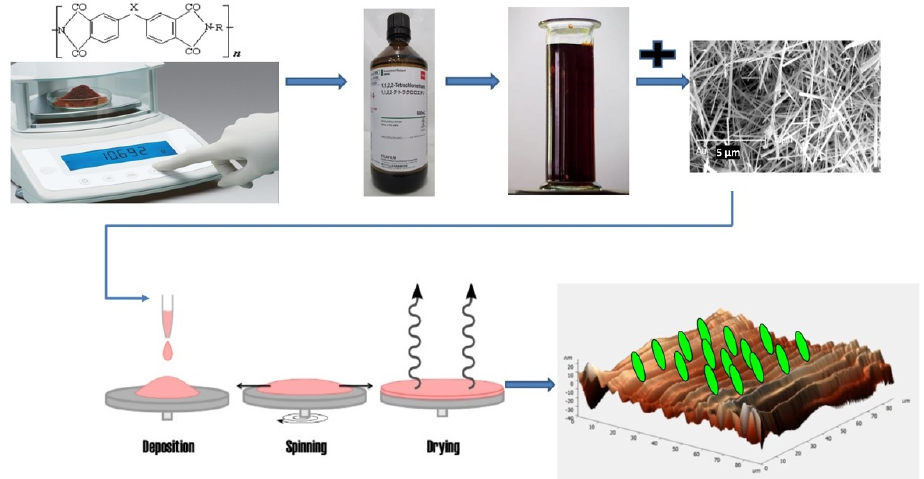
Figure 1. Schematic illustration of the process for preparing the relief structure of the PI film surface with WS 2 nanotubes as dopants, and the subsequent orientation of the LC molecules (green oblate features overlaid on the surface relief on the right-hand side).